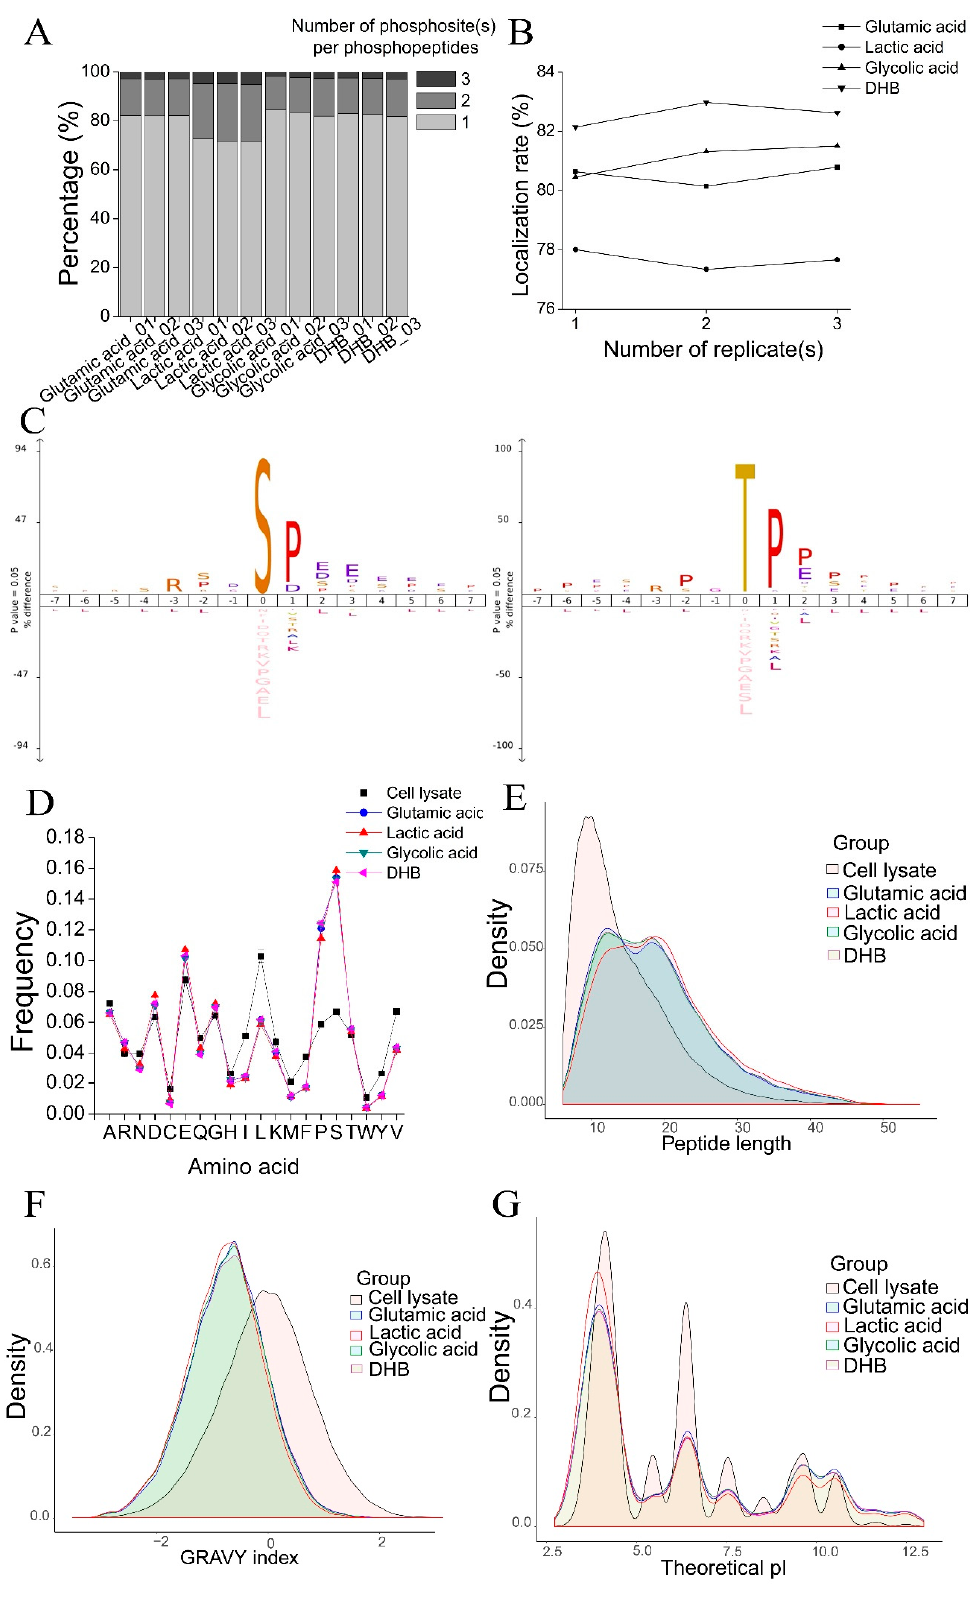
Figure 3. Comparison of the physicochemical characteristics of phosphopeptides identified with the four TiO 2 − based phosphopeptide enrichment methods. ( A ) The percentages of singly phosphory- lated, doubly phosphorylated, and triply phosphorylated peptides in the three replicates of the